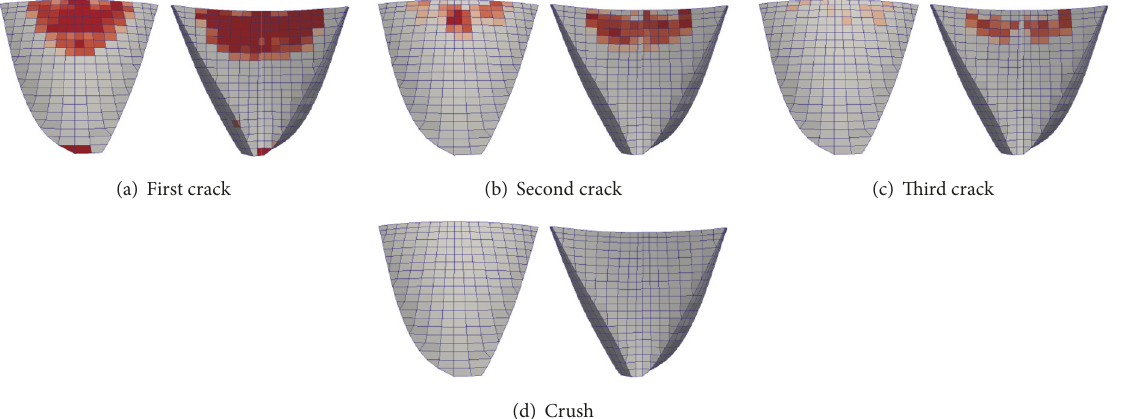
Figure 7: Damage distribution in upstream and downstream faces of pilot